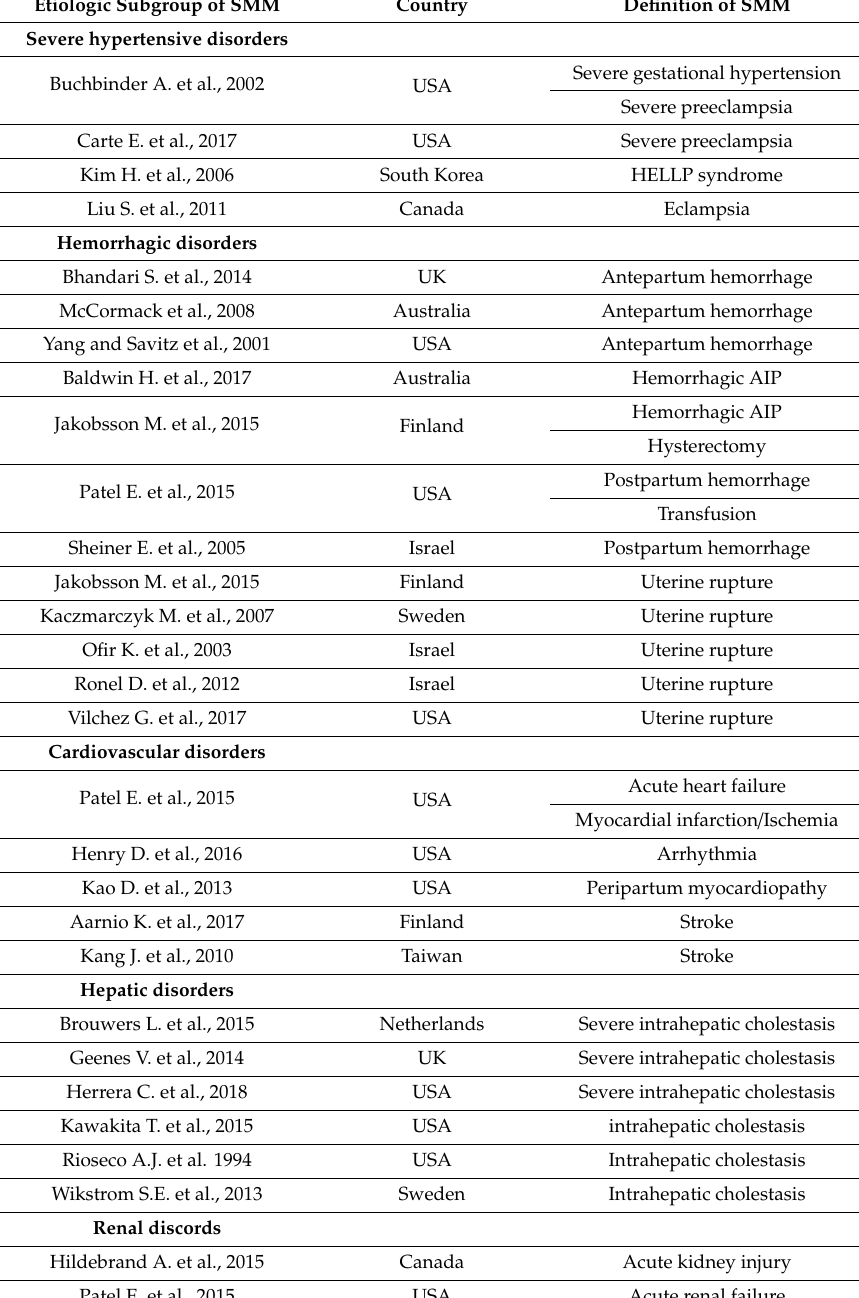
Table 1. Publications included in the systematic